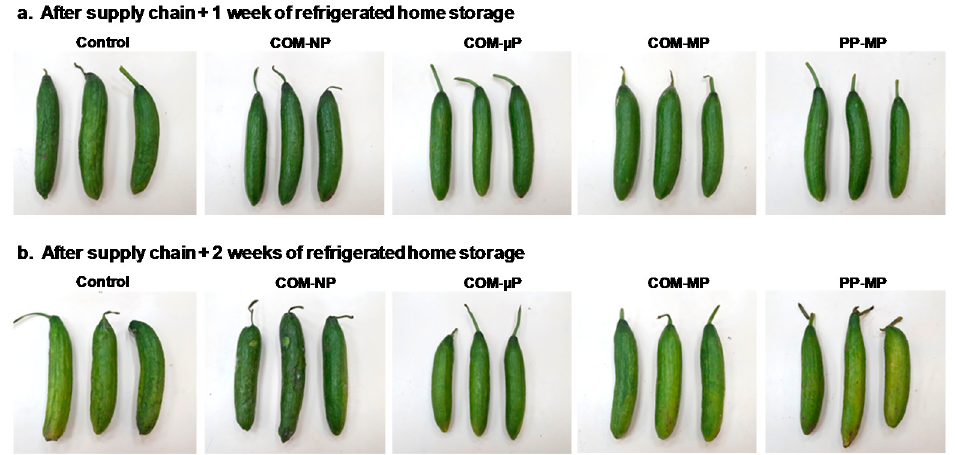
Figure 3. Photographs of cucumber fruits stored in different types of packaging under simulated farm-to-fork supply-chain conditions including distribution and marketing (2 days at 15 °C + 2 days at 22 °C) plus ( a ) 1 week or ( b ) 2 weeks of refrigerated home storage at 4 °C. COM—compostable, PP—polypropylene, µP—micro-perforated, MP—macro-perforated, NP—non-perforated.